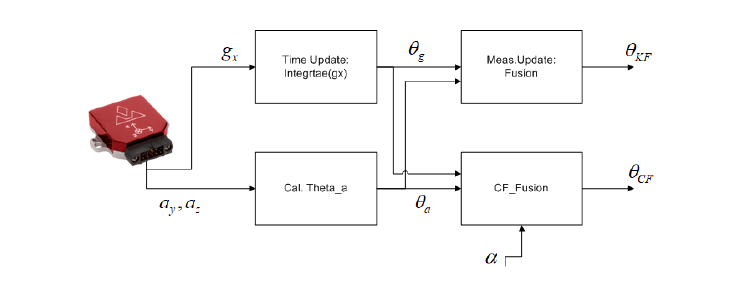
Figure 12. Complementary filter (CF) and Kalman filter (KF) processing for orientation estimation of the Mantis v2